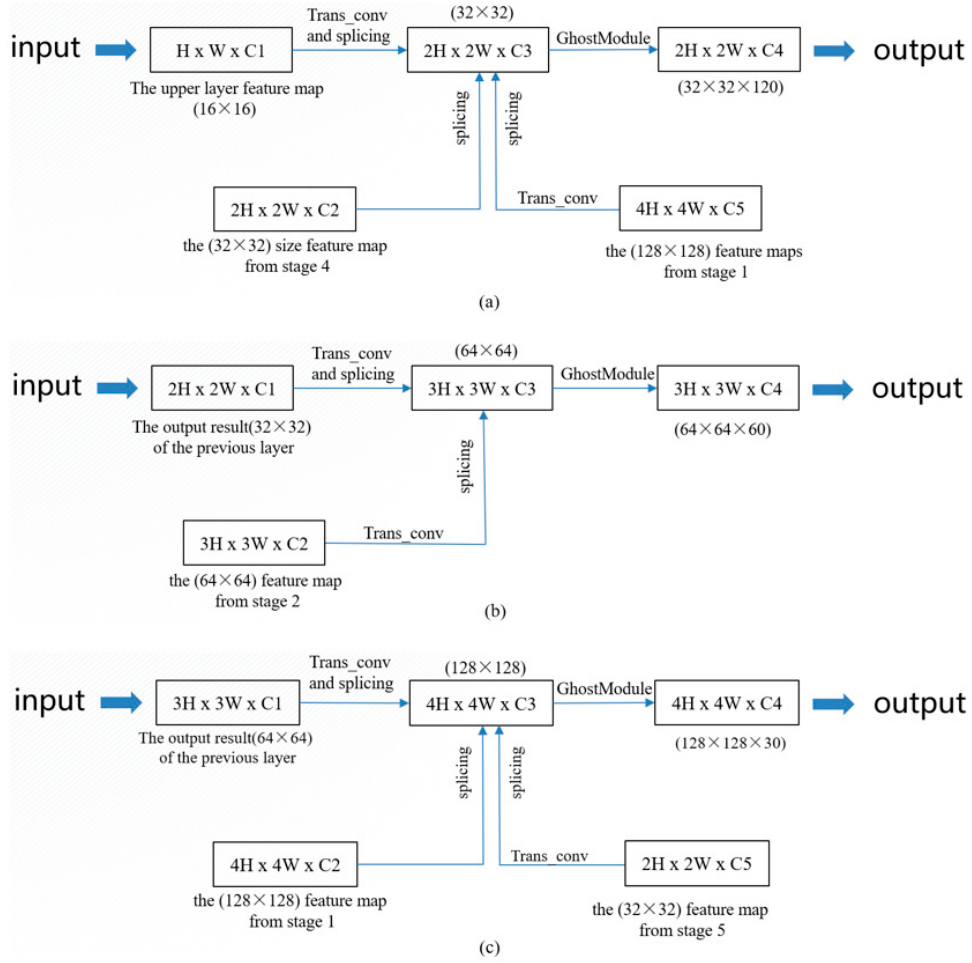
Figure 12. Lightweight multiscale fusion module. ( a ) The (32 × 32) feature maps in decoding, ( b ) the (64 × 64) feature maps in decoding and ( c ) the (128 × 128) feature maps in decoding.